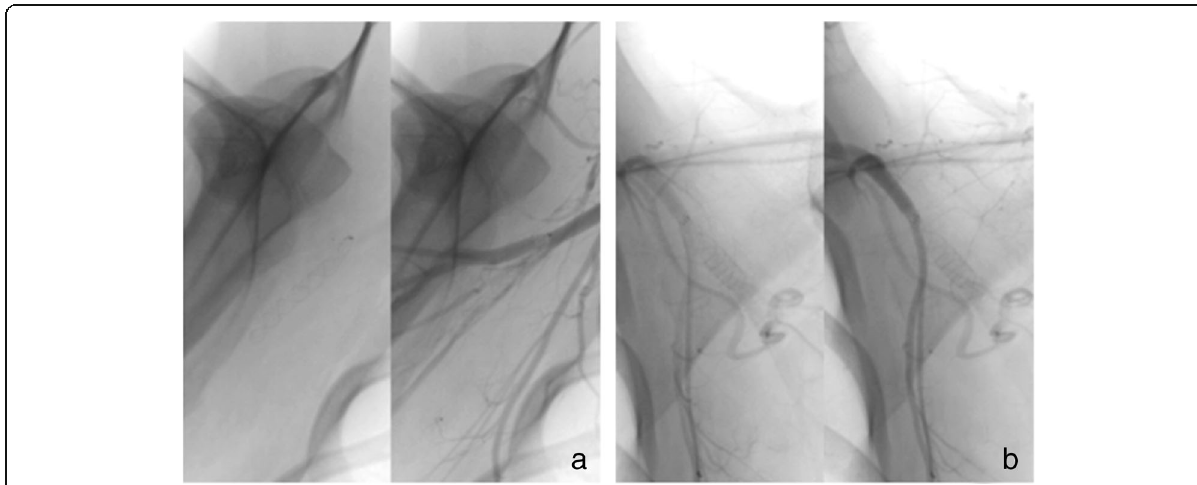
Fig. 4 Unsubtracted angiographic series of the right subclavian artery ( a ) and left subclavian artery ( b ) of subject number 2 (treated with ASA only), implanted with HPC-2 and HPC-3 coated p64 devices, respectively, at day 28 (final angiographic control). a The right FDS almost occluded by an extensive in-stent thrombosis. b Complete occlusion of the left-sided